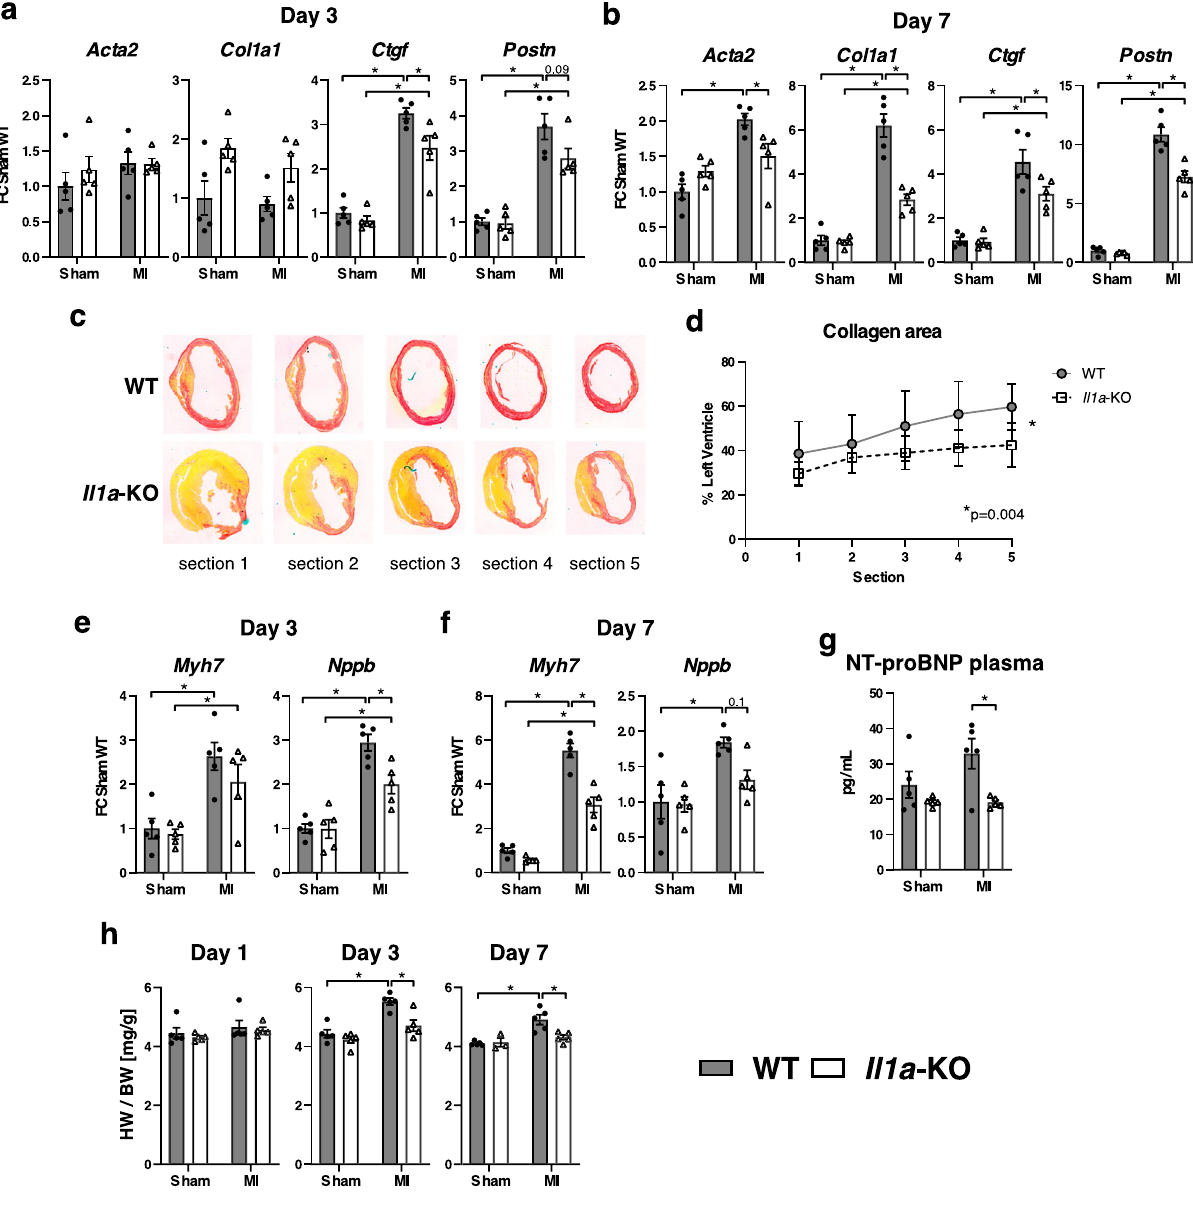
Figure 4. IL-1α-deficiency attenuates pro-fibrotic and hypertrophic signaling in infarcted myocardium. ( a ) mRNA expression of markers of myocardial fibrosis ( Acta2: alpha-2 smooth muscle actin, Col1a1 : Collagen α-1 chain, Ctgf : connective tissue growth factor, Postn : periostin), at day 3 and ( b ) day 7 after MI or sham surgery. ( c ) Representative histological cross-sections of IL-1α WT and IL-1α KO hearts stained for collagen fibers deposits with picrosirius red, 2 weeks after MI. Sections 1–5 were respectively cut 1, 2, 3, 4 and 5 mm below the ligation towards the apex. ( d ) Quantification of collagen surface expressed as percentage of LV surface in IL-1α WT (N = 5) and IL-1α KO hearts (N = 6) for each sections. ( e , f ) mRNA expression levels of the hypertrophy markers Myh7 (Myosin heavy chain β) and Nppb ( NT-proBNP) at day 3 ( e ) and day 7 ( f ) after MI or sham surgery. mRNA expressions of target genes were detected by RT-PCR, normalized to Rps18 housekeeping gene expression and expressed as fold-change (FC) over sham WT. ( g ) Plasma levels of NT-proBNP measured by ELISA seven days post-MI or sham surgery. ( h ) Heart weight to body weight ratios 1, 3 and 7 days post-MI or sham surgery. ( a , b , e – h ) N = 5/group. * p < ejection fraction (Fig. 5e , p = 0.07 ANOVA, p = 0.06, t test). The reduction of LV remodeling was further sub- stantiated by the smaller heart weight and HW/TL ratio in KO mice (Fig. 5f). The same differences persisted (except from ejection fraction and fractional shortening) when only animals with infarct size > 40% LV were compared (Table 1). We then sought to determine whether comparable effects on cardiac remodeling would occur in mice with a conditional deletion of IL-1α in cardiomyocytes. The conditional deletion was verified by PCR for Il1a floxed